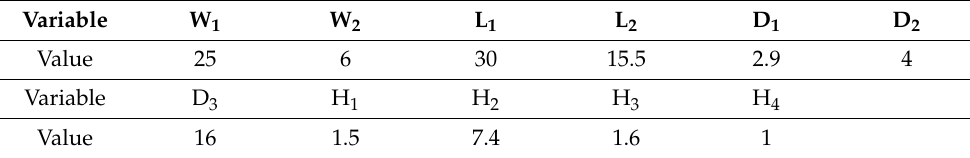
Table 2. The values of monopole and microstrip line variables (unit: